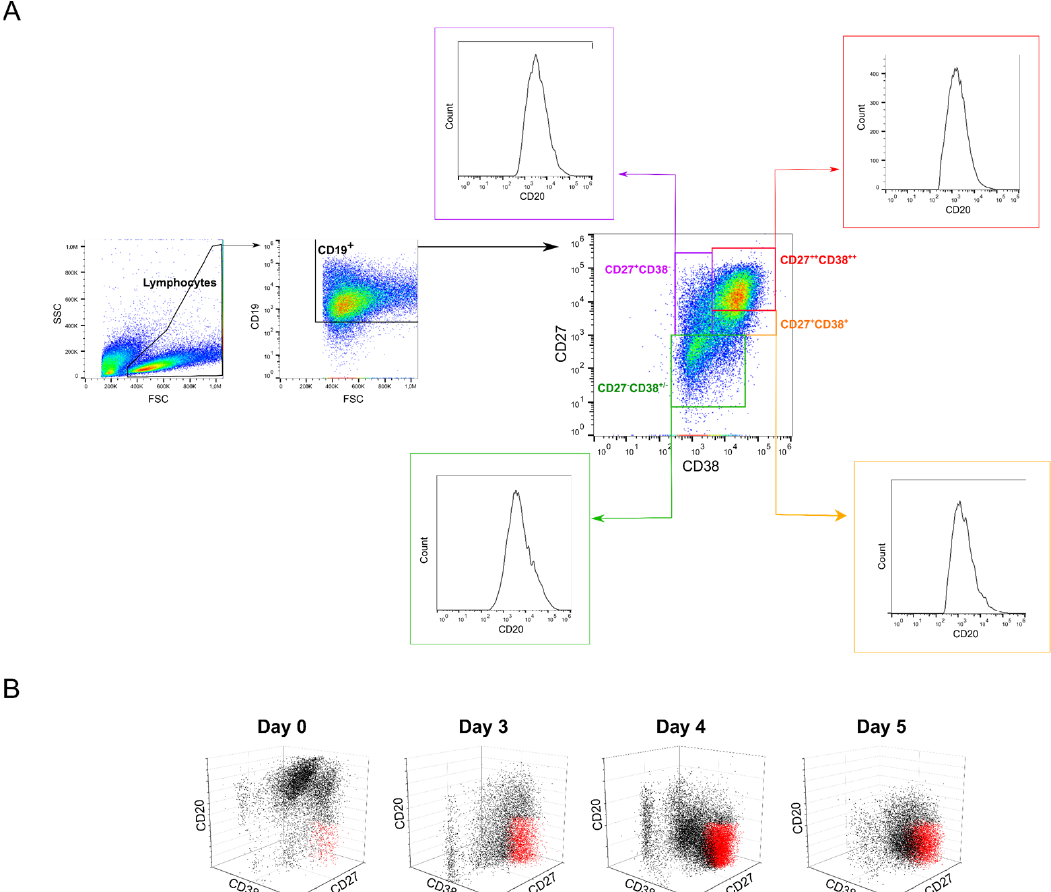
Figure 5. Evolution of the B cell population during the cultivation. ( A ) Gating strategy for the analysis of the B cell subsets. Naïve: CD19 + CD20 + CD27 − CD38 − /+ (green); Memory: CD19 + CD20 + CD27 + CD38 − (purple); GC: CD19 + CD20 − /+ CD27 + CD38 + (orange); Plasma CD19 + CD20 - CD27 ++ CD38 ++ (red) cells. ( B ) Representative 3-parameters analysis of B cell subpopulations on day of thawing (day 0) and after 3 to 5 days cultivation.